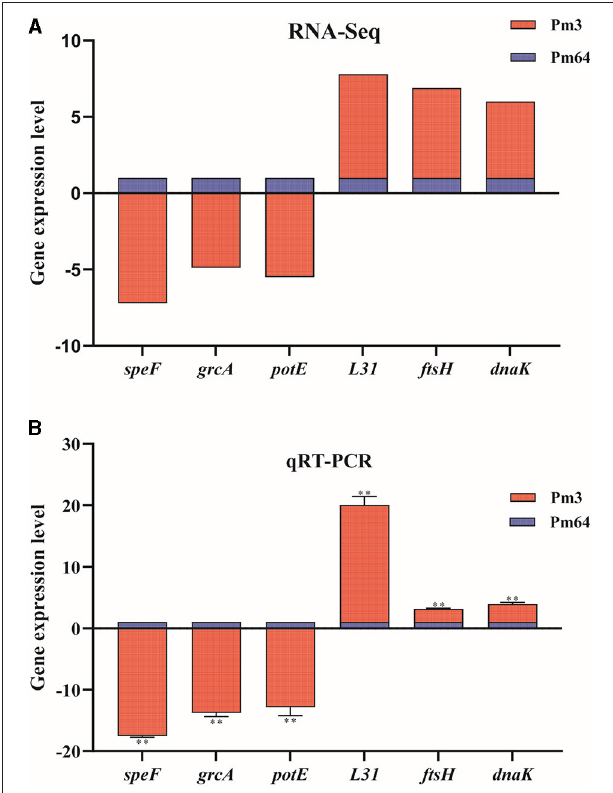
FIGURE 8 | Expression level validation of part of virulence factor-related DEGs ( n = 3). (A) The mRNA expression (RNA-Seq) of virulence factor-related DEGs in Pm3/Pm64. (B) The mRNA expression (RNA-Seq) of virulence factor-related DEGs in Pm3/Pm64. Results were representative of two independent experiments, with three replicates per group, analyzed by multiple comparative analysis and expressed as means ± SD (* p < 0.05, ** p <